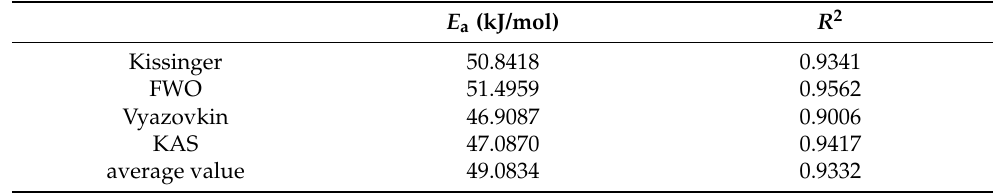
Table 5. E a and R 2 values were obtained by Kissinger, FWO, Vyazovkin, and KAS methods.